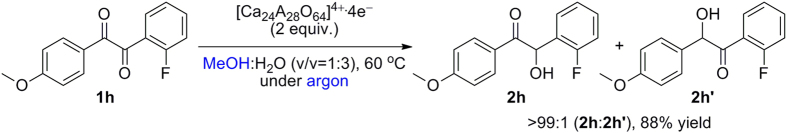
Regiospecific reduction of unsymmetrical 1,2-diketone.